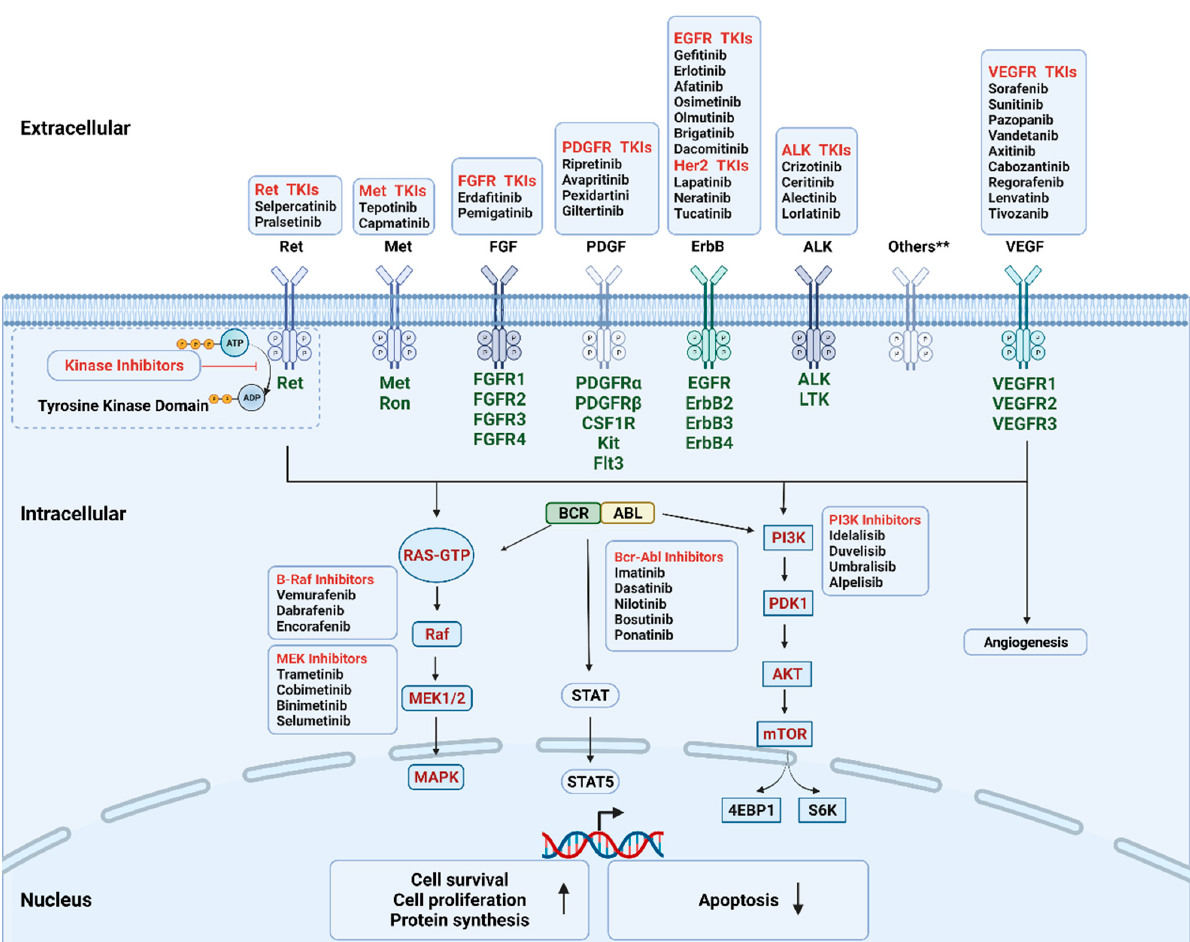
factor receptor; FGFR, fibroblast growth factor receptors; FLT3, Fms like tyrosine kinase 3; GIST, Gastrointestinal stromal tumors; Her2, Human epidermal growth factor receptor 2; MTC, Medullary thyroid cancer; NSCLC, Non-small-cell lung carcinoma; PDGFR, Platelet-derived growth factor receptors; PI3K, Phosphoinositide 3-kinases; Raf, Rapidly accelerated fibrosarcoma; RCC, Renal cell carcinoma; RTKs, Receptor tyrosine kinases; SLL, Small lymphocytic lymphoma; TGCT, Tenosynovial giant cell tumor; TKIs, Tyrosine kinase inhibitors.